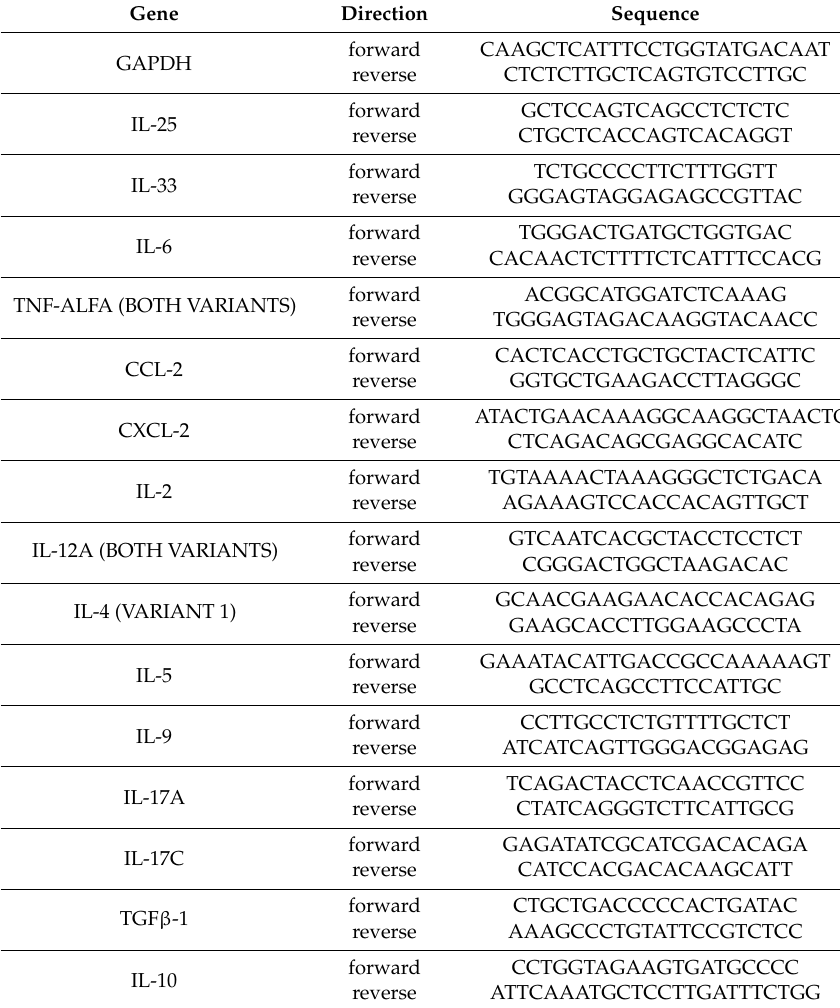
Table 2. Forward and reverse primers used for